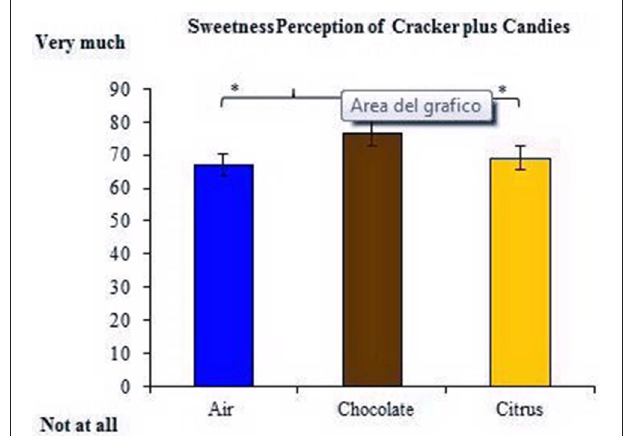
FIGURE 4 | The participants’ mean judgments of sweetness for both foods tasted regardless of the evaluation sequence, as a function of the different odor conditions. Error bars represent the standard errors of the means. Asterisks represent Newman-Keuls significant differences at * p < 0.01.